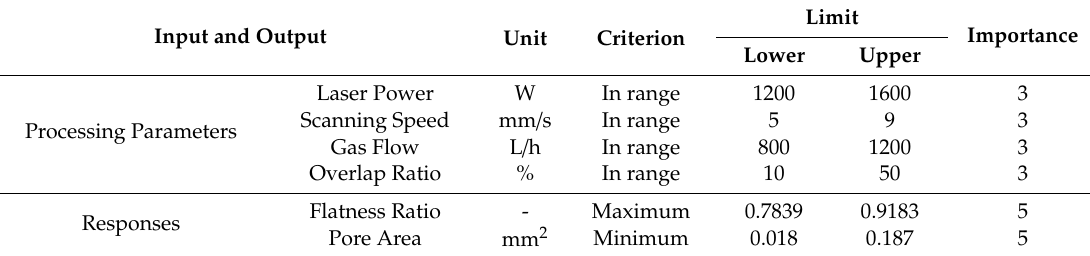
Table 8. Optimization criteria and